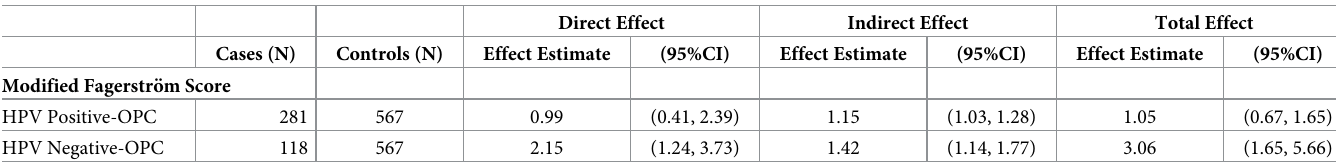
Table 4. The effect of HPV status on Oropharyngeal Cancer